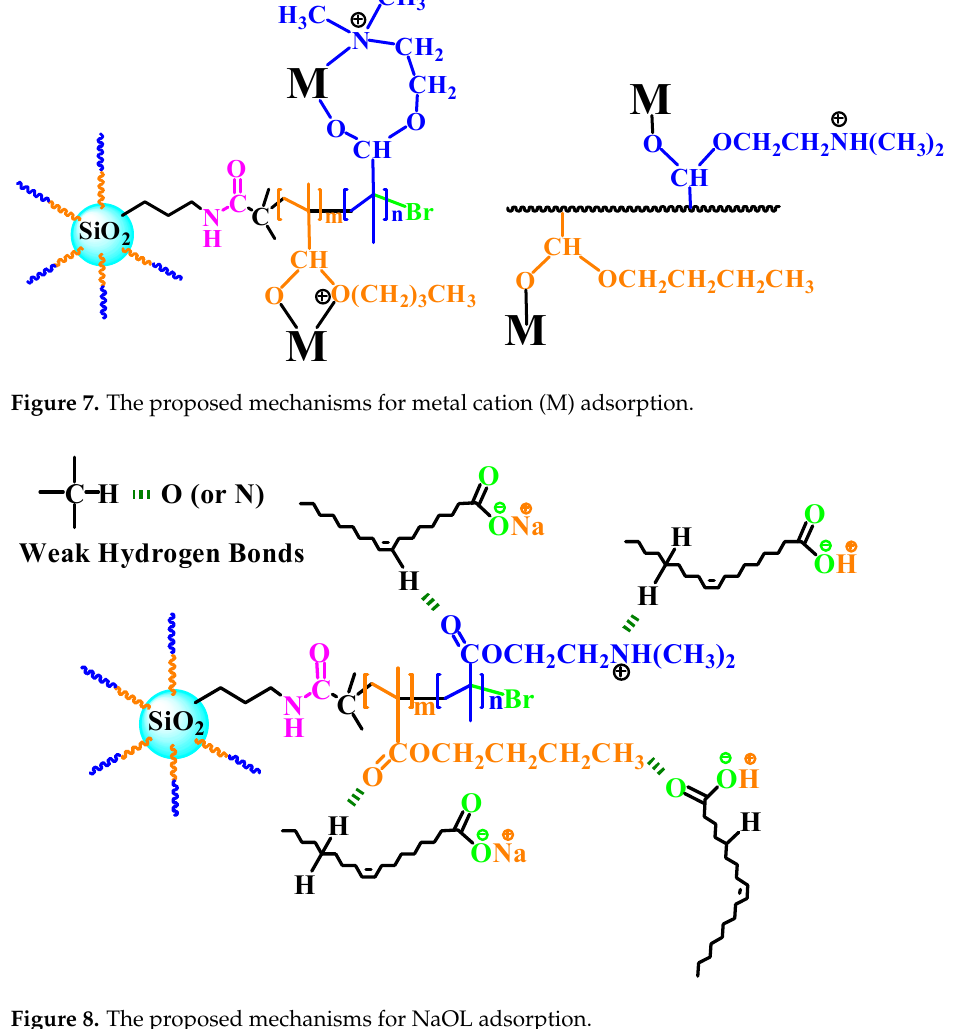
Figure 6. FTIR spectra of complexes of SiO 2 –g–PBMA–b–PDMAEMA with Cu( II ) and NaOL.